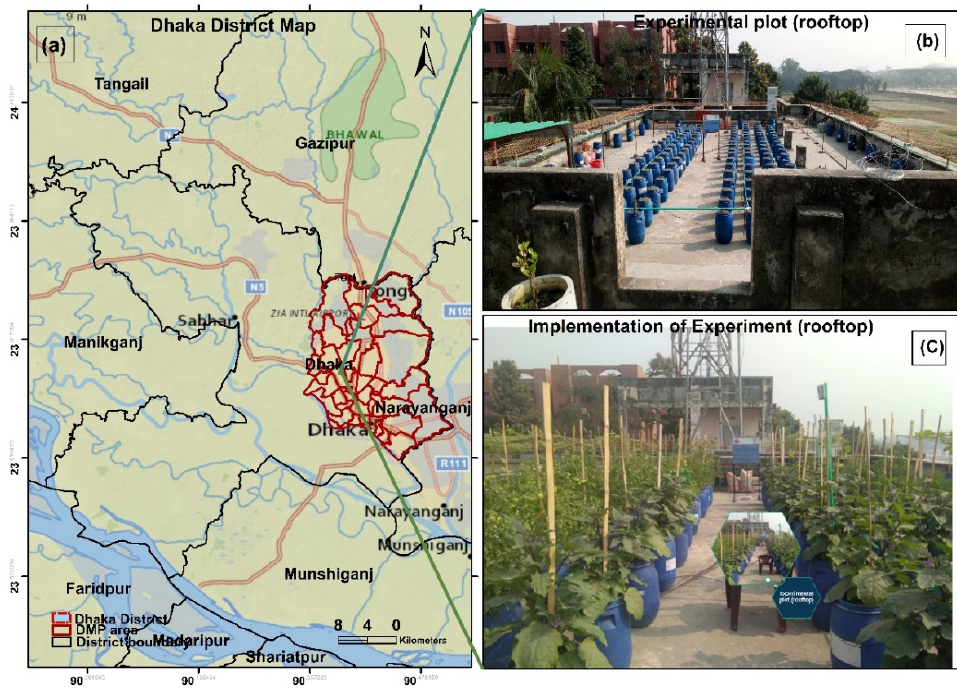
Figure 1. ( a ) Dhaka district map with base map; ( b ) Experimental plot (rooftop); ( c ) Implementation scenario of Experiment (URTA).